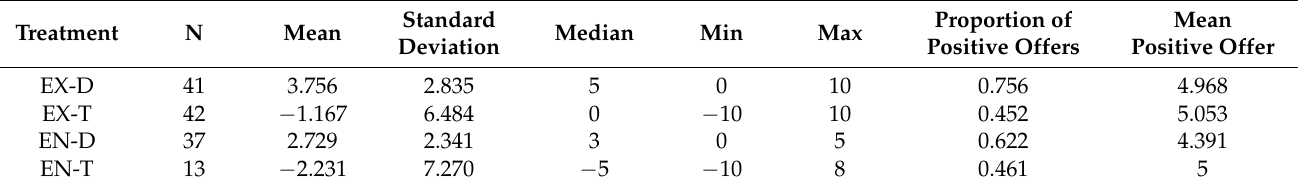
Table 1. Dictators’ giving across different